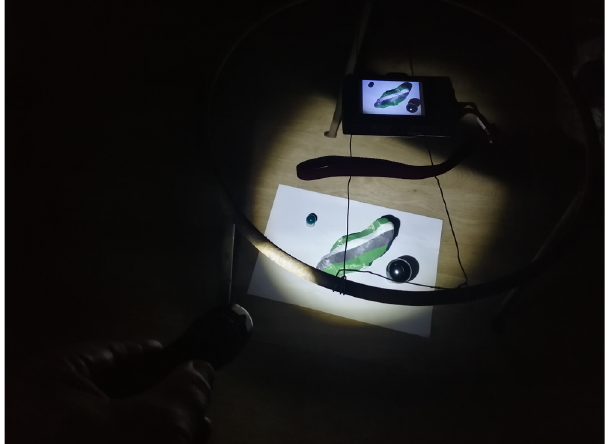
Figure 4: Nighttime shoot with improvised H - RTI